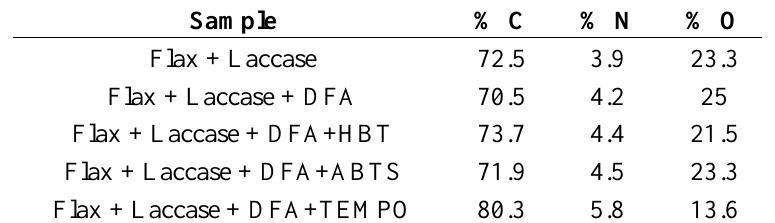
Table 3. XPS analysis of flax fibers after laccase treatment with dimer fatty amines (DFA).